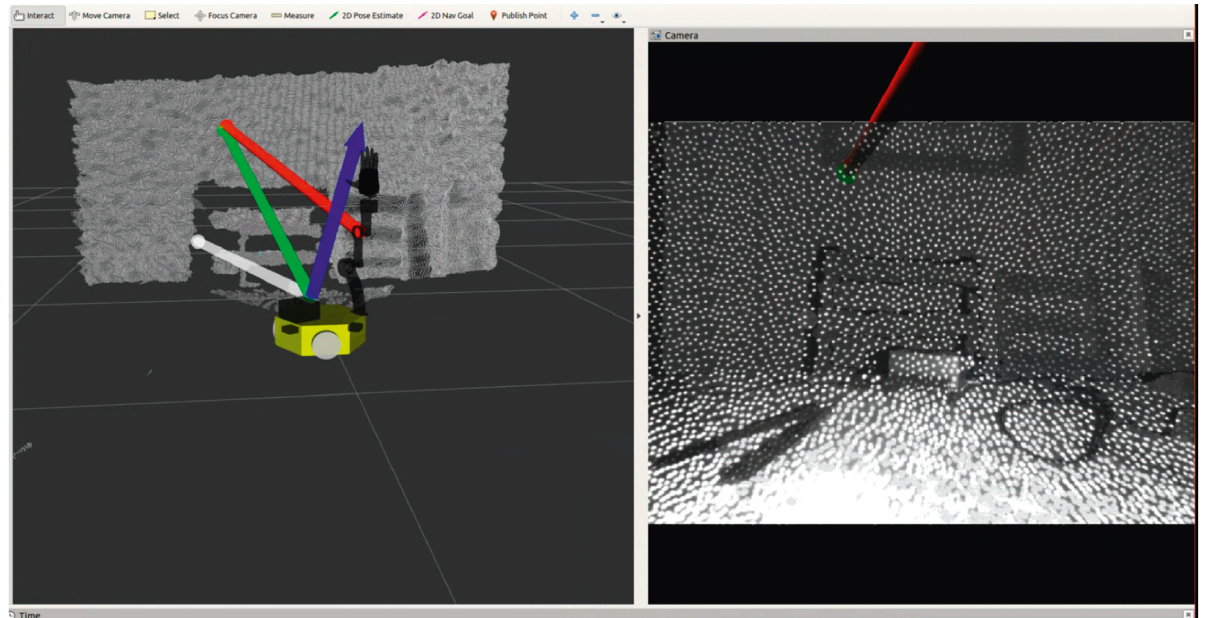
Figure 20: Sample unreachable